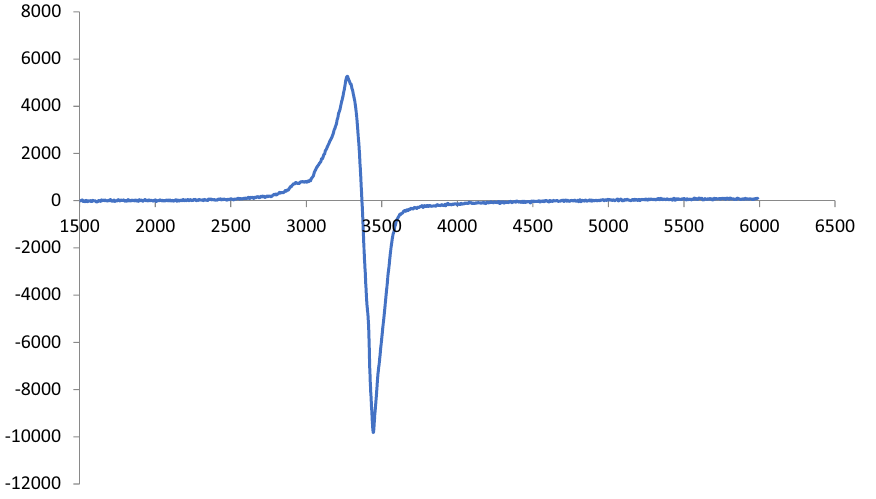
Figure 6. X-band EPR spectrum of Cu(II) complex 7 at room